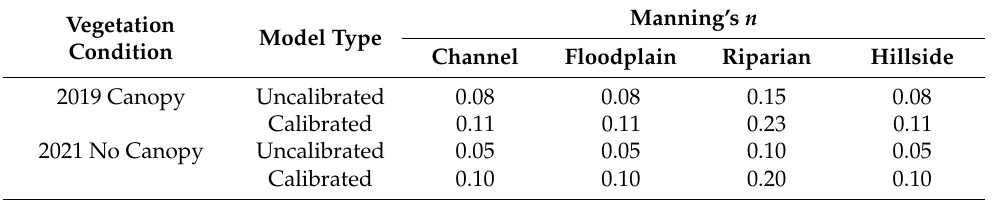
Table 2. Uncalibrated and calibrated Manning’s n roughness values for calibration